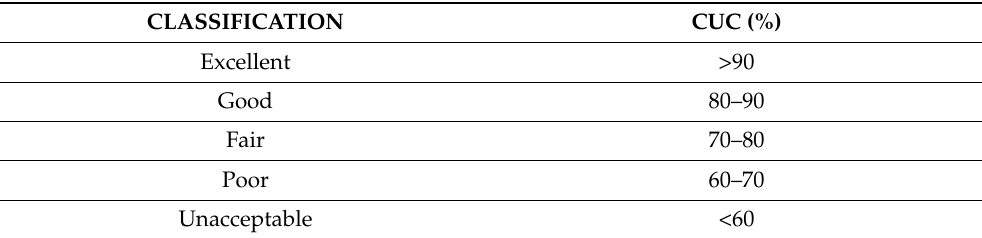
Table 3. Irrigation efficiency parameters classification according to the ASABE